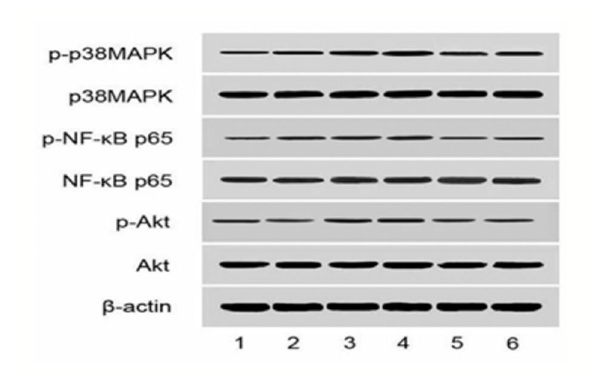
Figure 13. Western blot analysis of each group at the 3